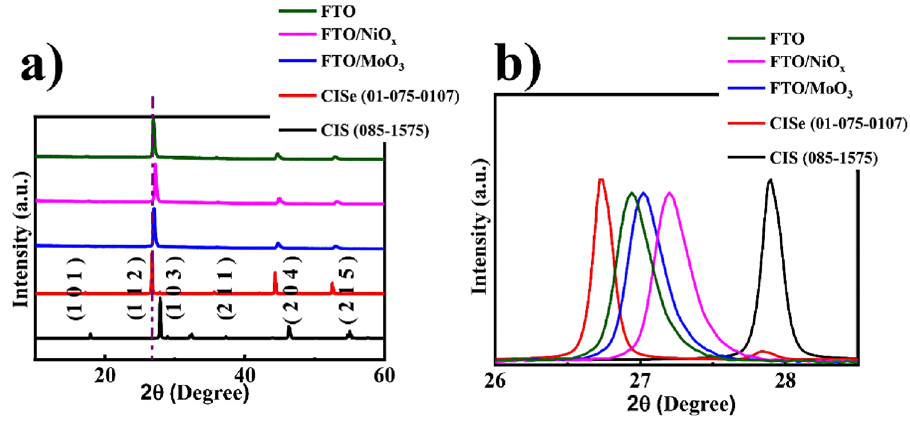
Figure 4. XRD pattern of CISe films on different